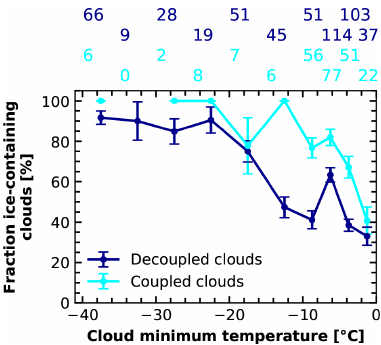
Figure B1. Same as Fig. 4 but also using a threshold in the potential temperature gradient to identify surface coupling.